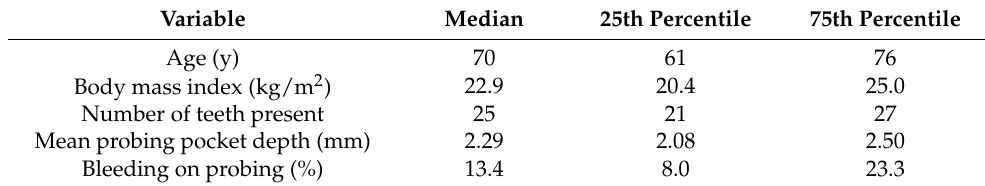
Table 2. Subjects’ characteristics ( n = 210).